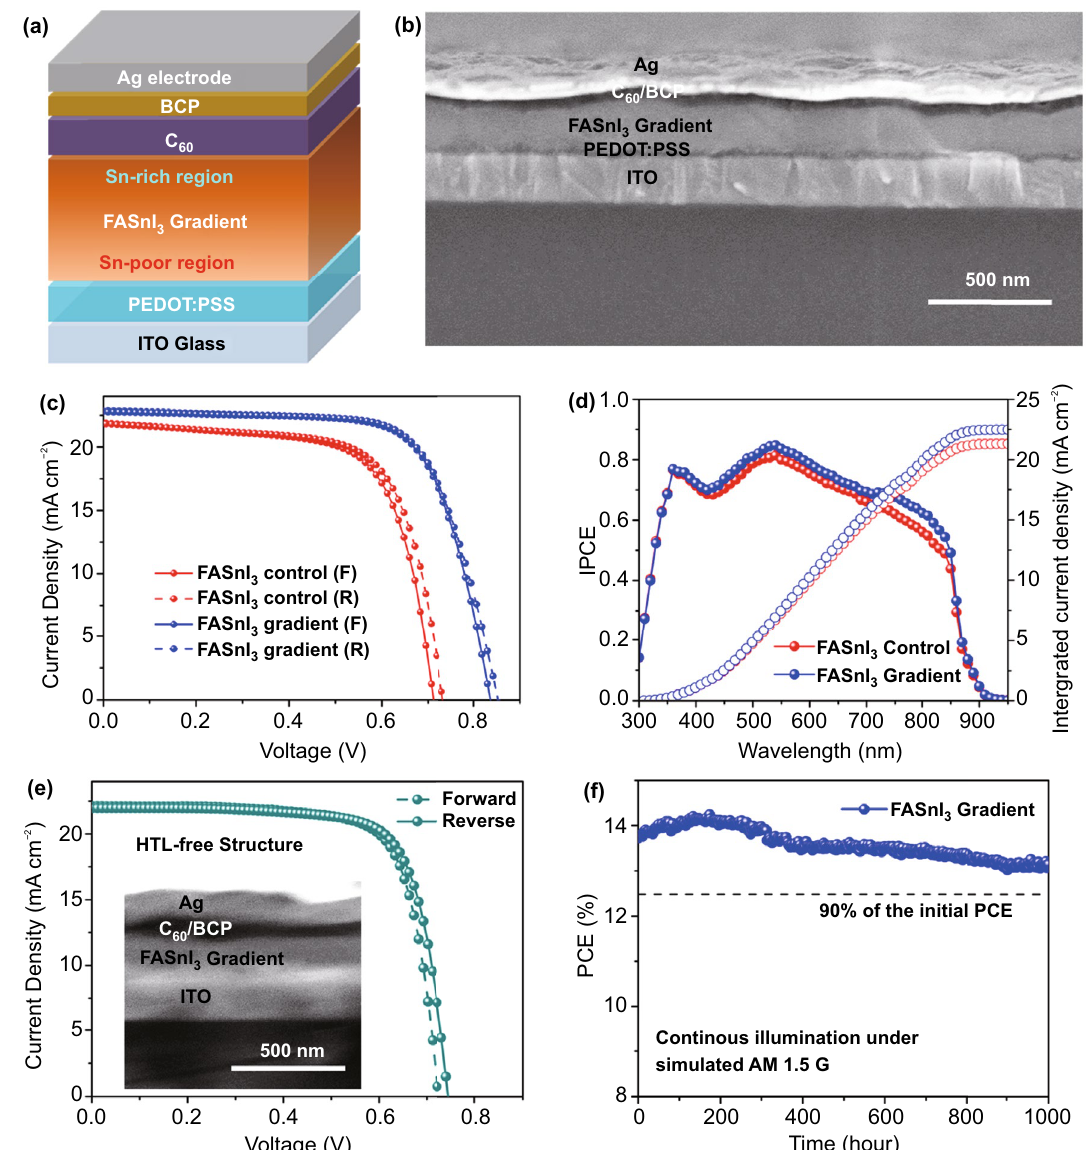
Fig. 5 a Schematic illustration of the gradient FASnI 3 -based inverted PSCs and b the corresponding device cross-sectional SEM image. c For- ward and reverse J–V curves of the best-performing FASnI 3 control and gradient PSCs. d IPCE spectra and the integrated current density of the FASnI 3 control and gradient devices. e Forward and reverse J–V curves of the HTL-free FASnI 3 gradient device (the inset shows the cross- section of the SEM image). f Operational stability test of the encapsulated FASnI 3 gradient PSC under simulated AM 1.5G light in